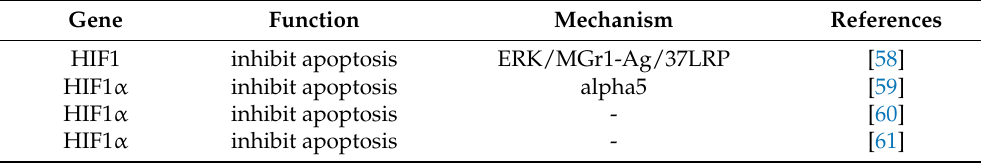
Table 3. HIF regulates gastric cancer progression by gastric cancer cell apoptosis.